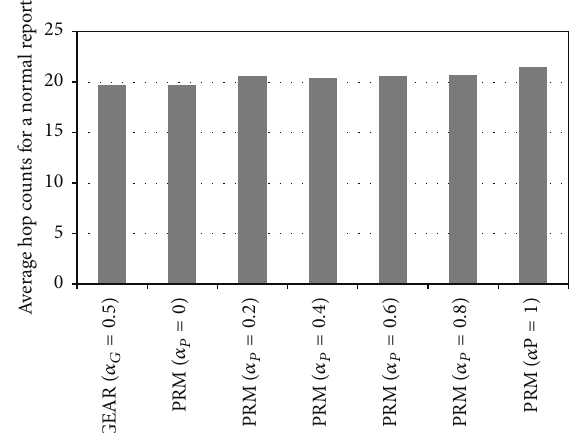
Figure 9: Average hop counts for a normal report.